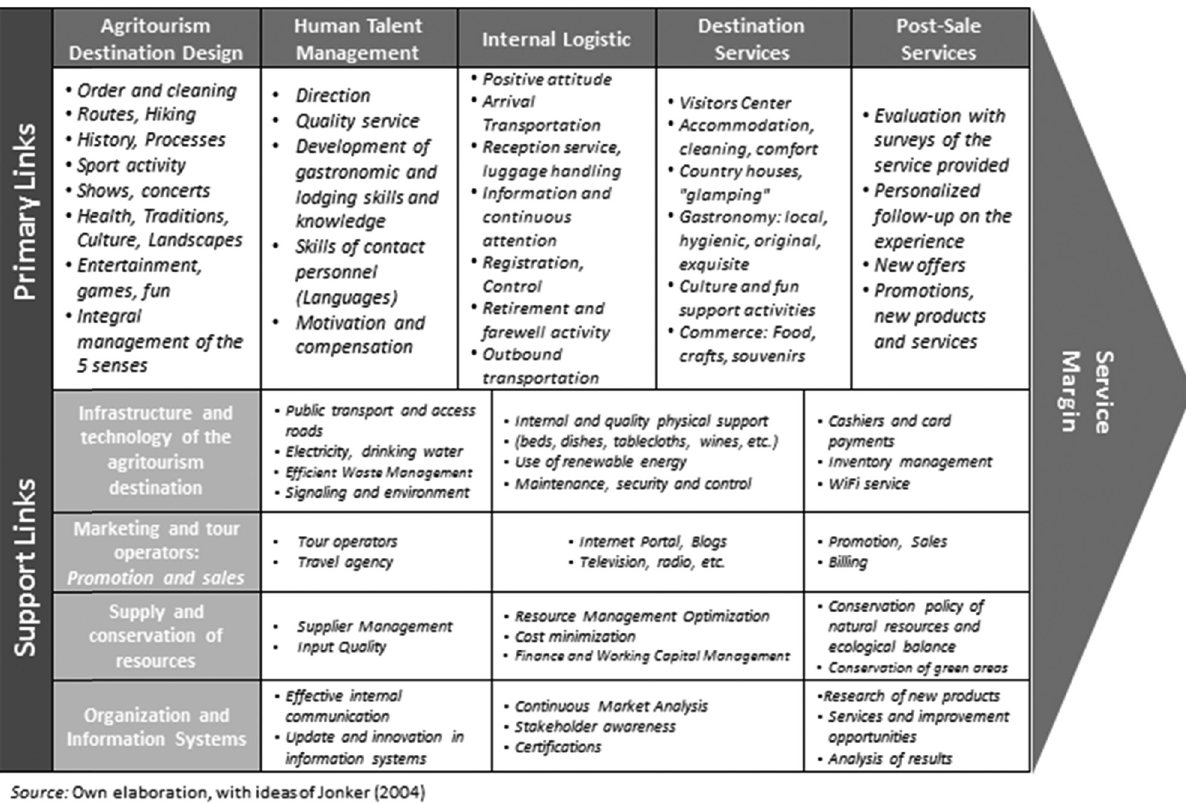
Figure 6: Breakdown of a proposed agritourism chain, where the elements of value in primary and support activities are shown. Source: own elaboration, with ideas of Jonker ( 2004 )